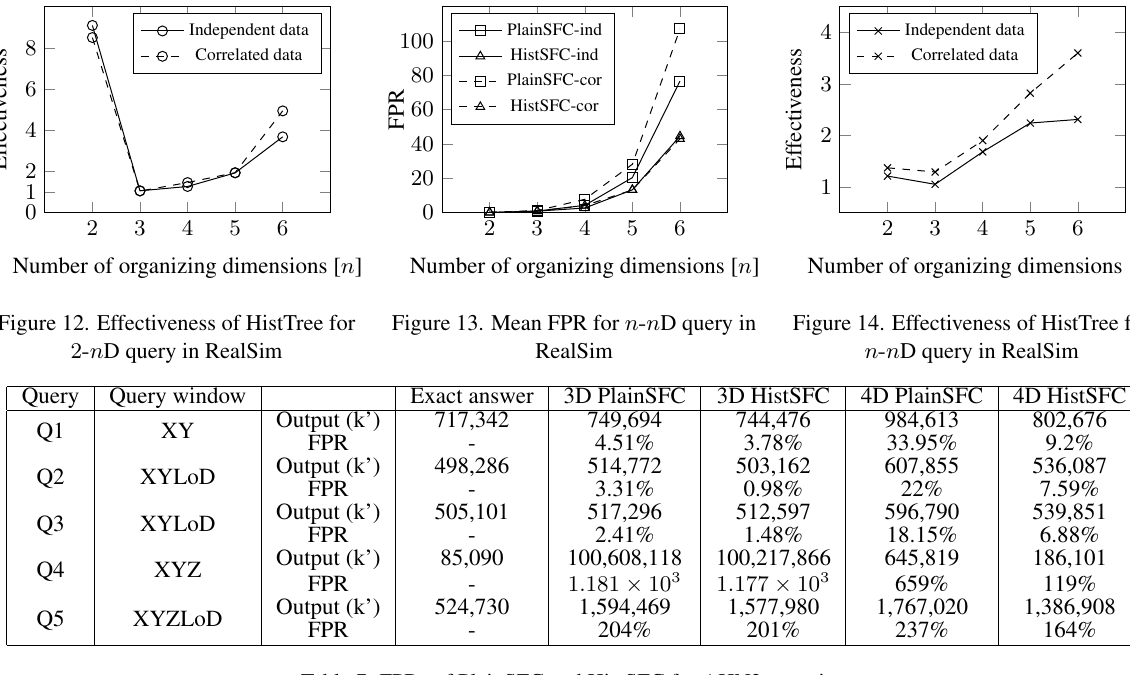
Table 7. FPRs of PlainSFC and HistSFC for AHN2